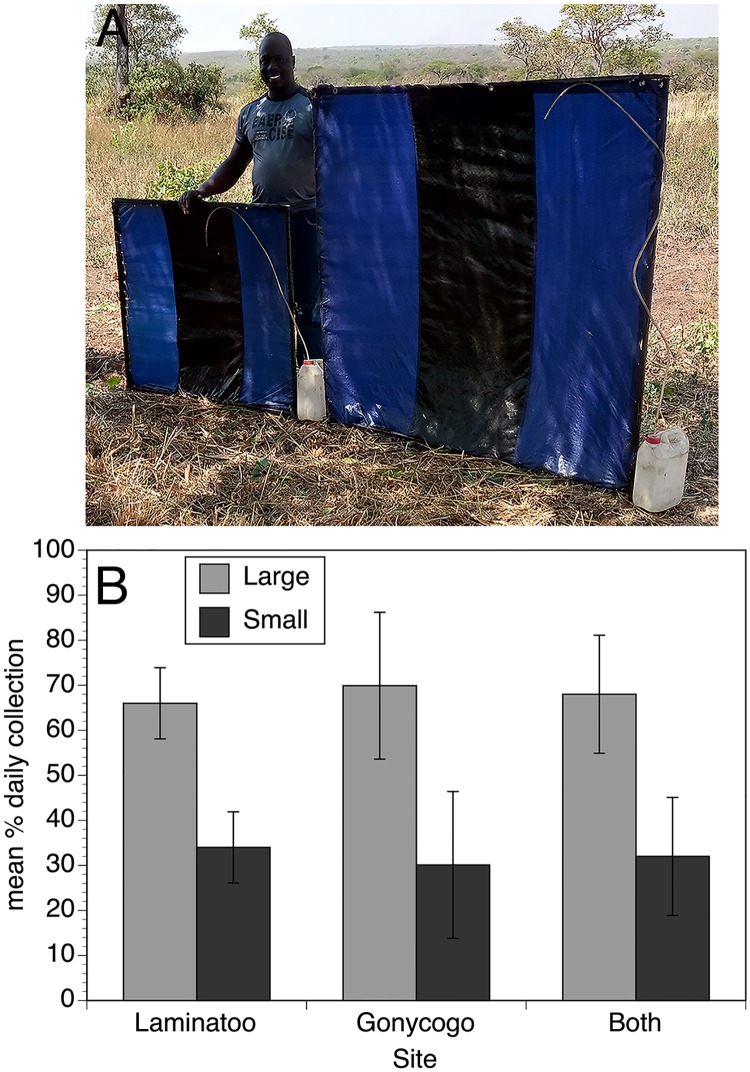
Relative performance of 1.5m and 1m square trap designs.Panel A: Photograph of the 1m and 1.5m trap designs. Panel B: Bars represent the relative performance of the 1m and 1.5m trap designs in Laminatoo, Gonycogo and data from both communities combined. Data are presented as the mean percentage of the total collection by day, normalizing for variations in the absolute number of flies collected on each day, as described in Materials and Methods. Error bars indicate the standard deviation associated with the means. The analysis from Laminatoo incorporated data collected from 18 paired trials, while the analysis from Gonycogo included 20 paired trials. Raw collection data for this study may be found in the S1 Table.